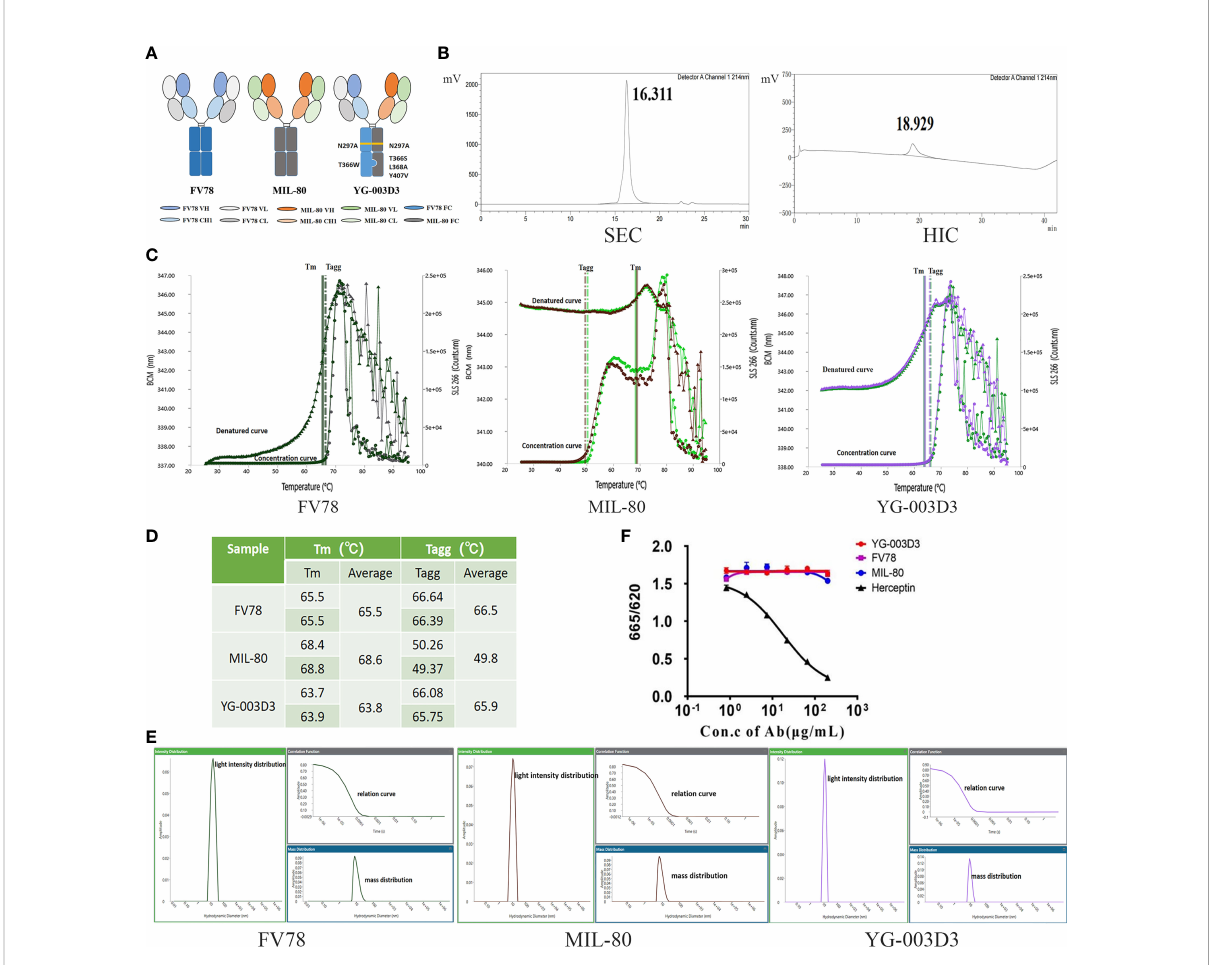
FIGURE 1 In vitro assembly and quality analysis of YG-003D3. (A) Schematic structure of YG-003D3, Fv78, and MIL-80. Among them, YG-003D3 involves the engineering of Fc, mainly including Fc mutation T 366 S; L 368 A; Y 407 V for the hole with the anti-LAG-3 variable region and T 366 W for the knob with the anti-PD-1 variable region. The structure of ‘ knob ’ and ‘ hole ’ promotes the formation of heterodimers in the heavy chain. The N 297 A mutation eliminates Fc-mediated cross-linking of target cells and immune cells. (B) SEC-HPLC results con fi rmed that the assembled antibody did not contain semi-antibody and some small fragment components. Since the hydrophilicity and hydrophobicity of Knob and Hole proteins were different, HIC-HPLC was used to further analyze whether there was a Knob/Hole homodimer in the assembled antibody. (C, D) The denaturation temperature (Tm) and aggregation temperature (Tagg) of the bispeci fi c antibody and two parental antibodies and YG-003D3 were detected. (E) Mass and light intensity distribution of YG-003D3, Fv78, and MIL-80, which suggests that the YG-003D3 antibody was homogeneous. (F) The binding activity of BsAb YG-003D3 to human